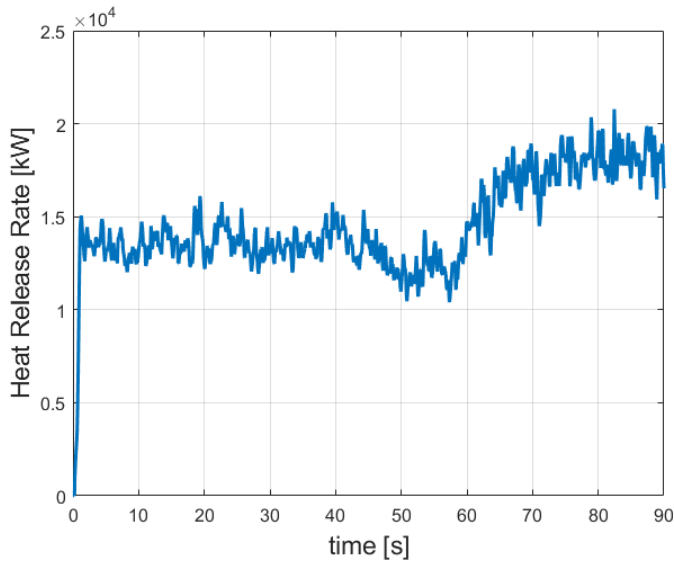
Figure 6. Heat Release Rate (HRR) of the pet-coke particles.